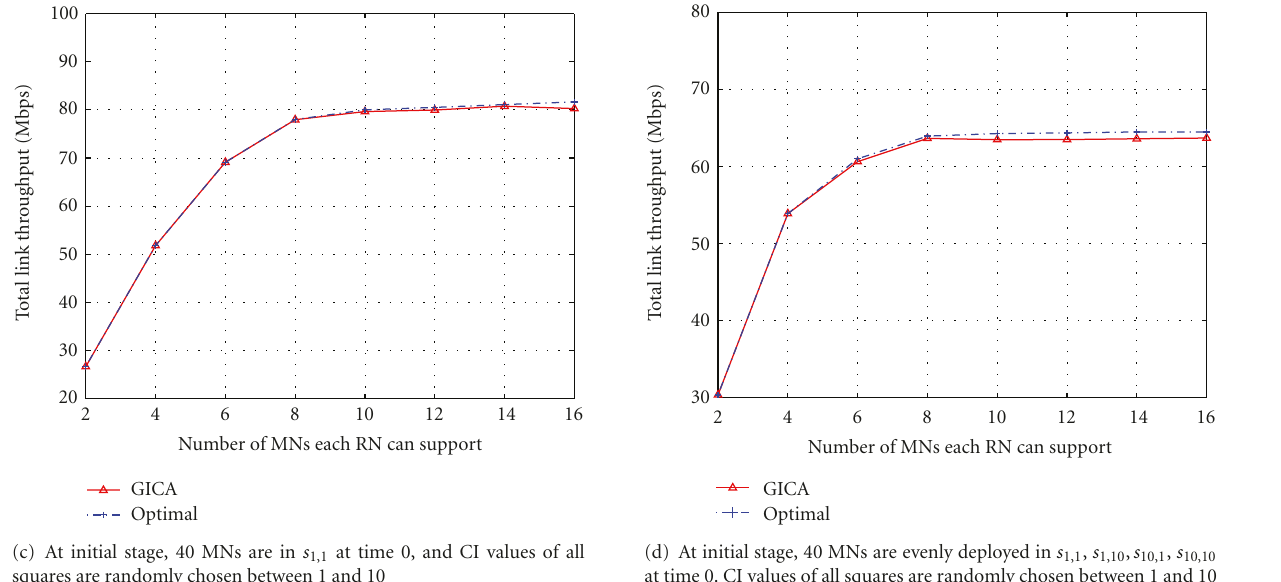
Figure 11: Average covering percentage over the entire relief process versus di ff erent capabilities of RNs in four scenarios. r = 1 . 5 L , M = 5.